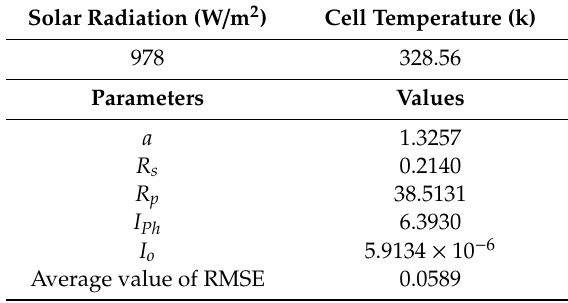
Table 1. Extracted five parameters of single-diode PV model at the MPPT.